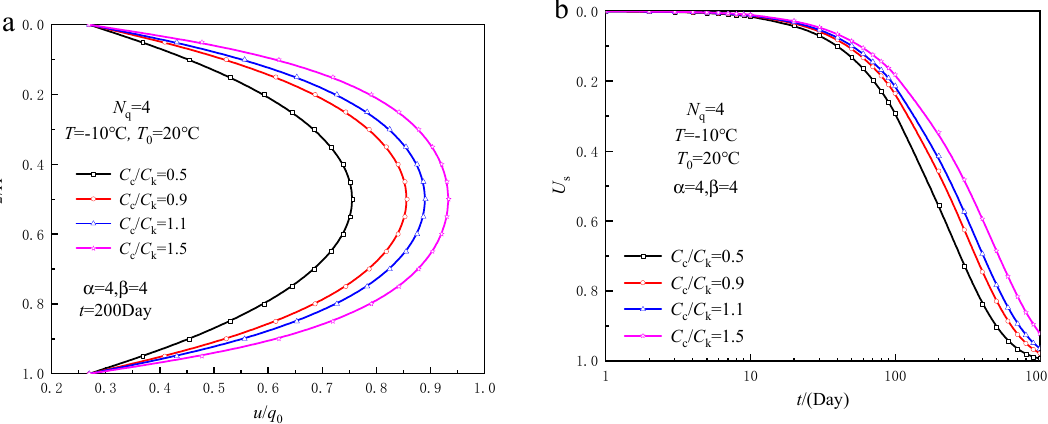
Figure 7. Influence of the pile of C c / C k : ( a ) the distribution of excess pore water pressure, and ( b ) the distribution of the degree of the consolidation defined by settlement.